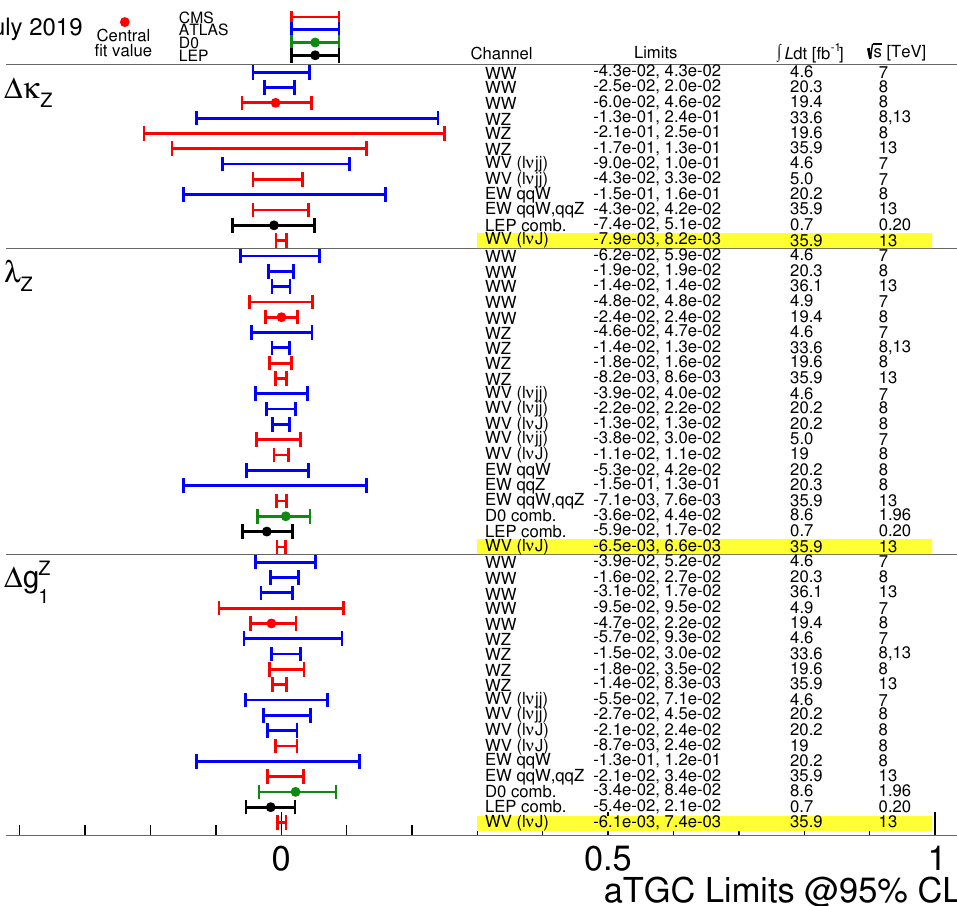
Figure 7 . Comparison of the observed limits on aTGC parameters in the LEP parametrization from di(cid:11)erent measurements. The highlighted rows represent the limits obtained from this measurement. (cid:1) (cid:20) have been converted to limits on (cid:21) (cid:13)